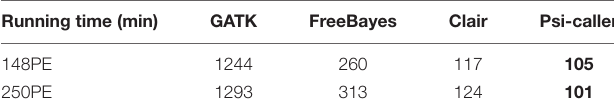
TABLE 2 | Performance of the benchmarked variant callers.